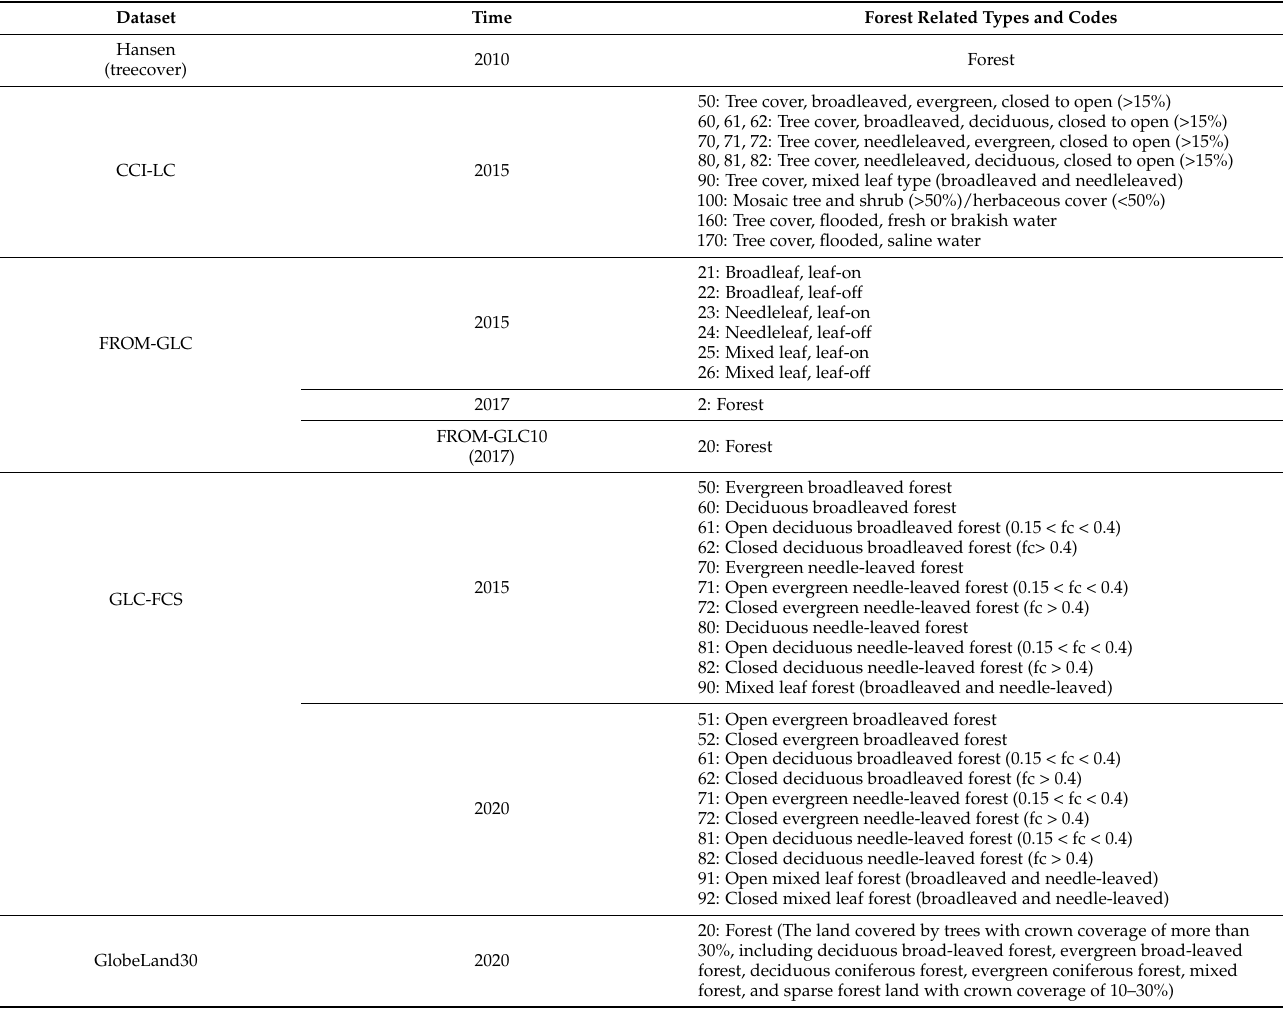
Table 2. Forest classification systems from the eight datasets and the conversion